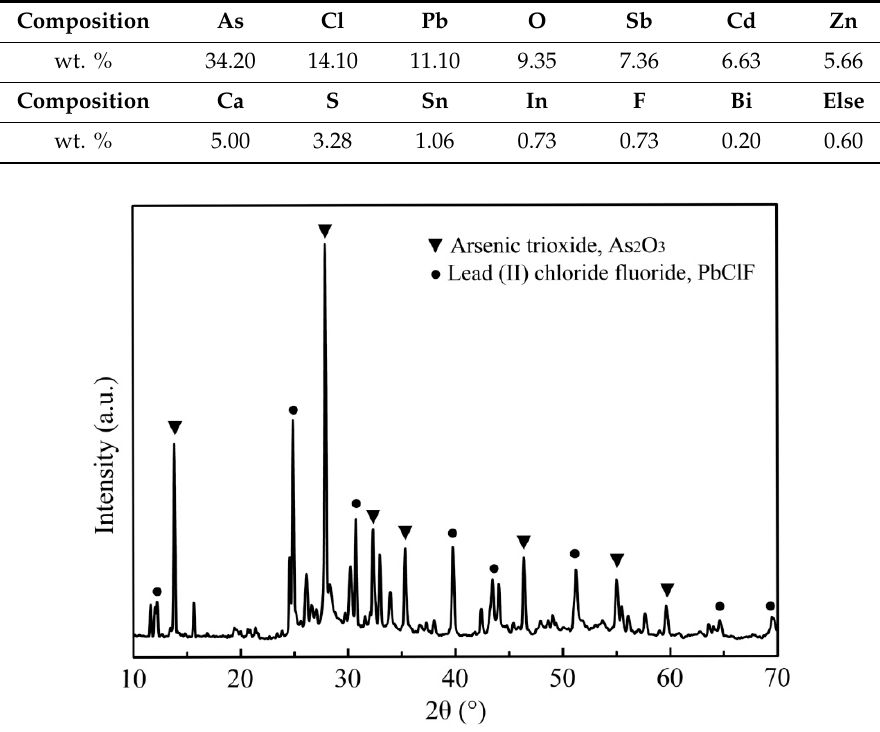
Table 1. Main chemical composition of the high-arsenic dust.